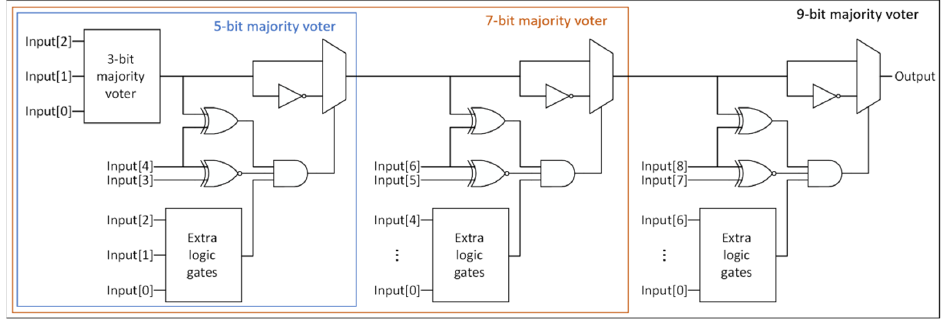
Figure 3. Hierarchical approach in [32] for 9-bit majority voter design.